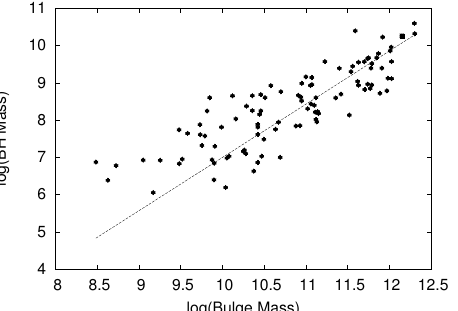
Figure 7. The galaxy sample of Saglia et al. [99] with three additional galaxies in the black hole mass vs. galaxy stellar mass diagram (stars), while the position of OJ 287 is given as a solid square. The dashed line represents the correlation found by Portinari et al. [100] for galaxies in the upper-right hand part of the graph around redshift